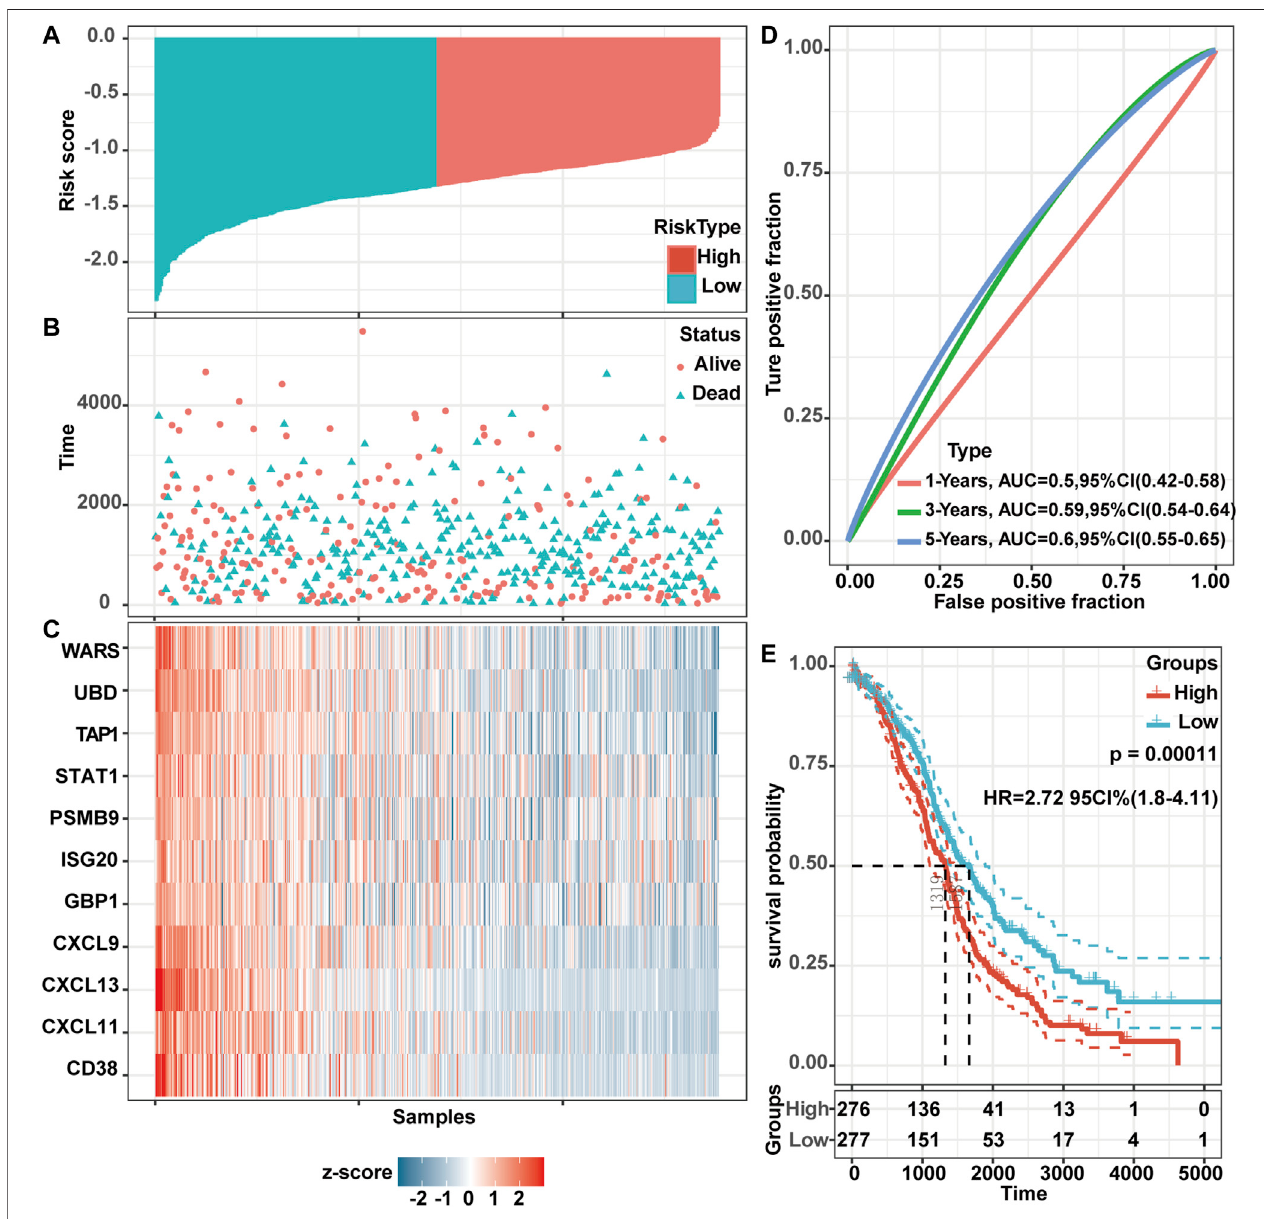
FIGURE8| TAP1andCXCL13weresigni fi cantlyrelated totheOSofOVpatientsthroughmultivariate coxregressionanalysisinTCGA.Riskscoredistribution (A) , survival status (B) , and validation DEGs expression (C) for multivariate analysis for patients in high-risk and low-risk groups. (D) Time-dependent ROC curve analysis. AUCs were set at 1 year, 3 years, and 5 years to evaluate the accuracy of the prognosis. (E) Kaplan-Meier curve analysis of OS in the low- and high-risk groups. The log-rank test was used to calculate the p -value.